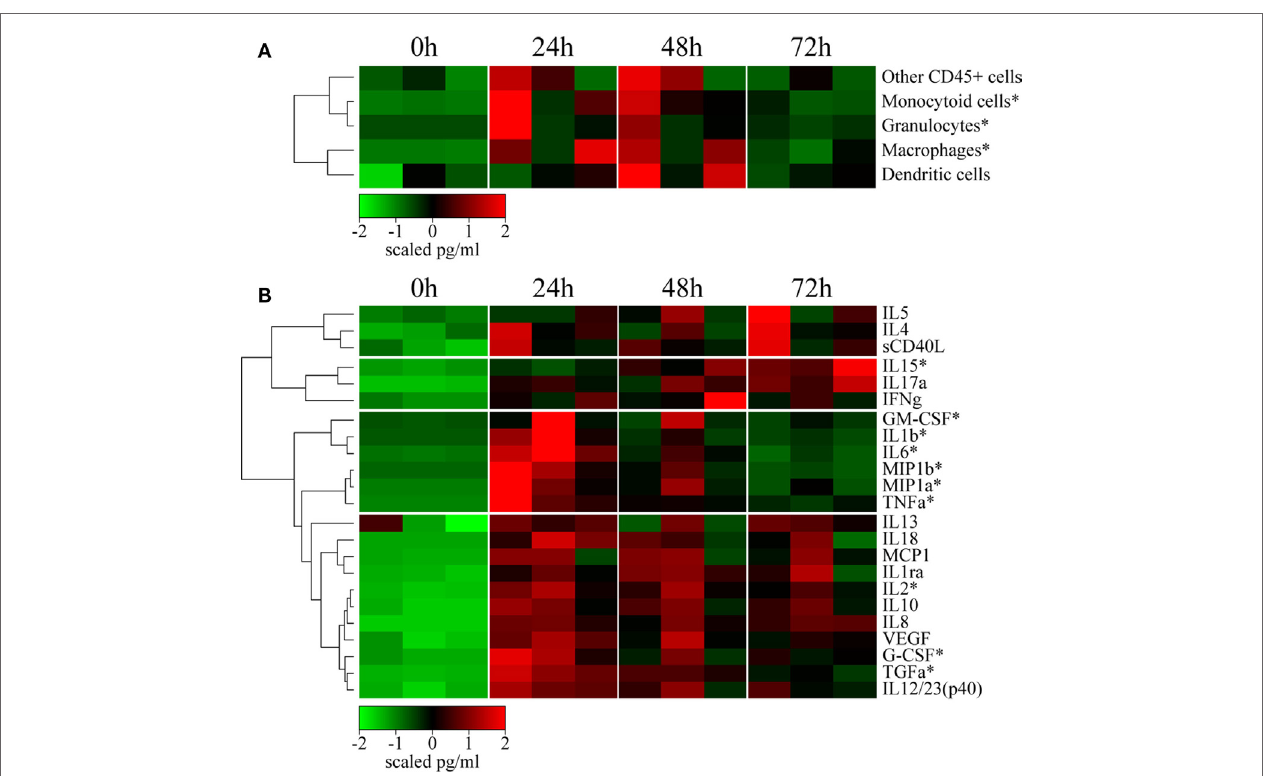
FigUre 3 | rMVA injection induces local cellular trafficking and cytokine release. (a) Heatmap representation of the cell counts in skin subset populations discriminated by flow cytometry. Cell populations were automatically sorted following hierarchical clustering represented by the dendrogram on the left. The number of cells was calculated by dividing the number of events by the weight of the biopsy. Values were standardized to display the same range of expression values for each cell population to properly visualize the cell population kinetics. See Figure S3A in Supplementary Material for gating strategies. (B) Heatmap representation of cytokine release in the skin after rMVA injection. Cytokine expression was automatically sorted following hierarchical clustering represented by the dendrogram. Values were standardized to display the same range of expression values for each cytokine to properly visualize the cytokine production kinetics. *0.05 > p - value > 0.01 in Friedman’s test over